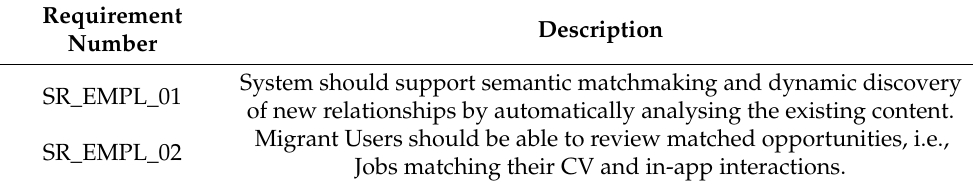
Table 2. Requirements relevant to Semantic Reasoning.